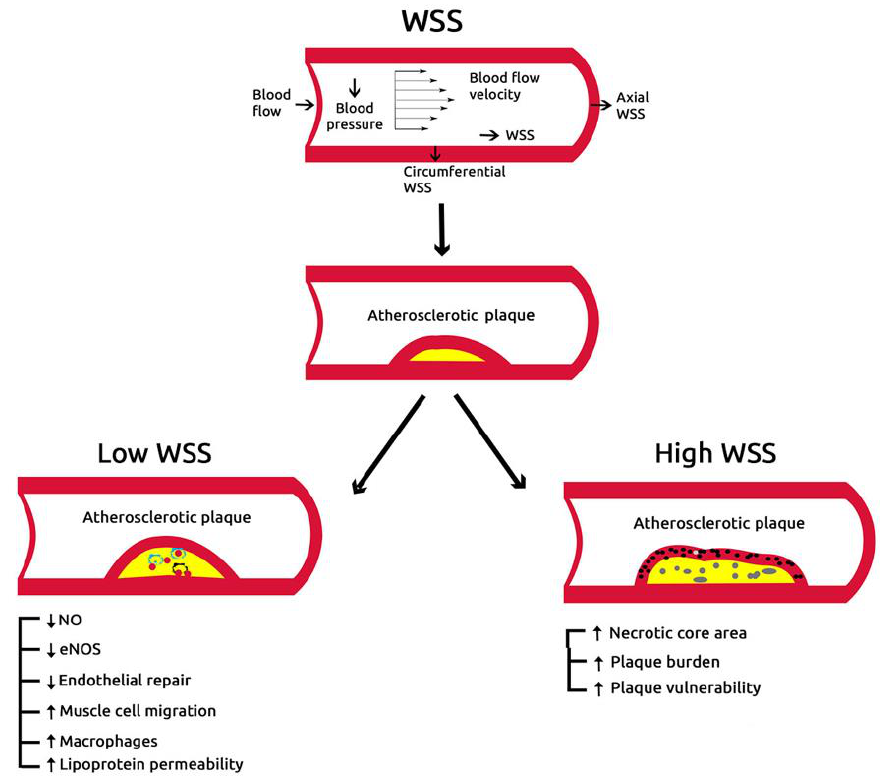
Figure 4. Role of wall shear stress in vulnerable plaque.